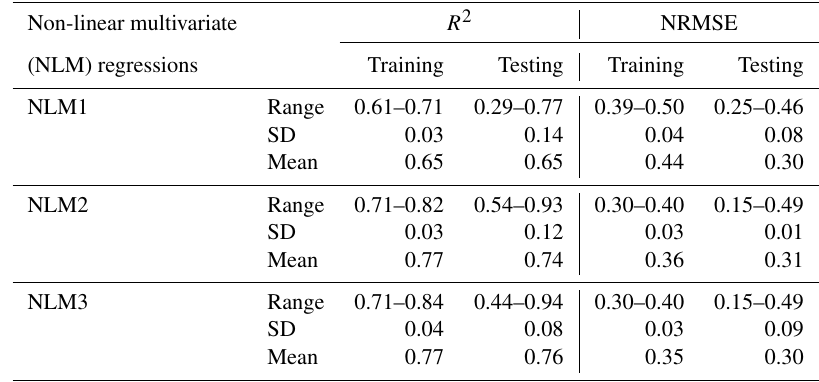
Table 6. The accuracy and sensitivity of the non-linear multivariate (NLM) regressions with different variables. Non-linear